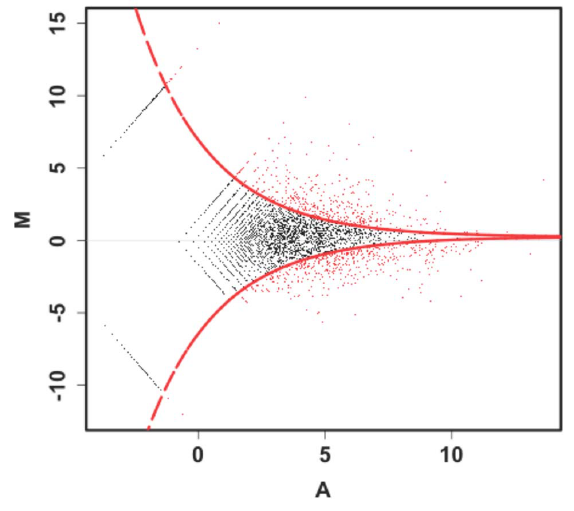
Figure 5. Comparision of the gene expression levels between the libraries of germinated (VDMG-b) Verticillium dahliae microsclerotia and non-germinated (VDM). Red dots represent differentially expressed genes in the VDMG-b library compared to VDM library using the Fisher’s exact test at P =0.001 and log2 Ratio $ 1.